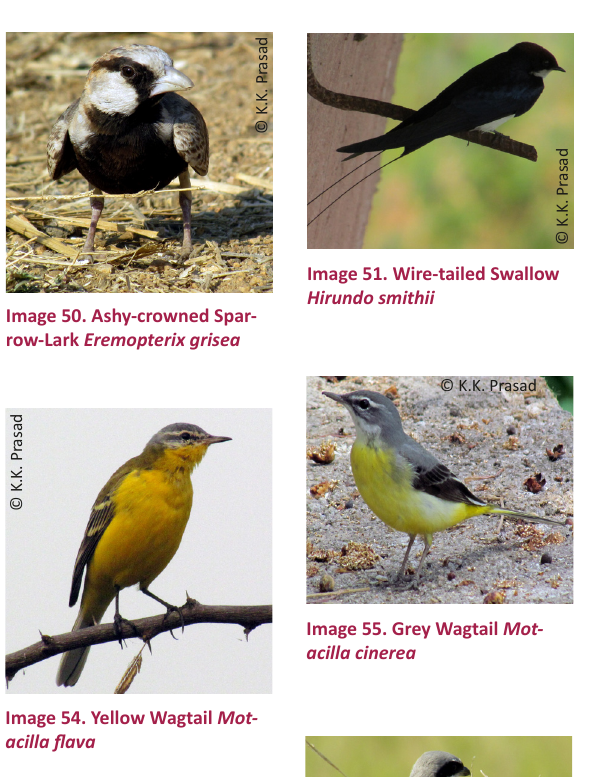
Image 57. Red-vented Bulbul Pycnonotus cafer